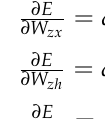
The weight matrix is combined to form the parameter weights. The loss function of ) 2 and the loss function is used to converge the loss the moment t is set to E t = 0.5 ( y d − y v t of the sample by performing a bias operation on each parameter weight. The update of each parameter after the convergence operation is shown in Formula (8).